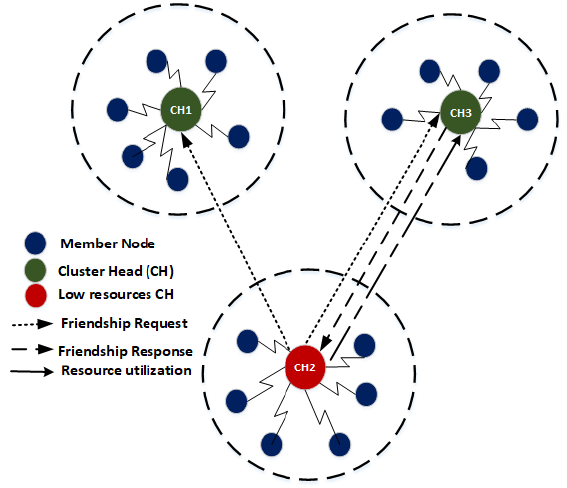
Figure 4. Cluster head